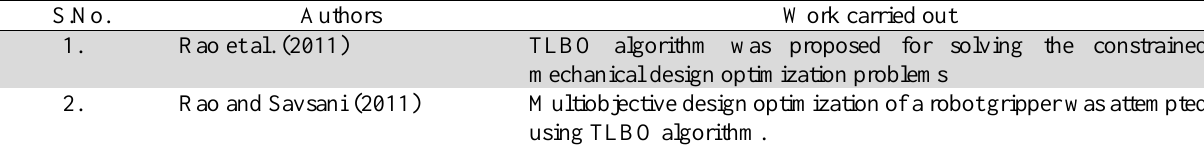
Authors Work carried out TLBO algorithm was proposed for solving the constrained mechanical design optimization problems Multiobjective design optimization of a robot gripper was attempted using TLBO